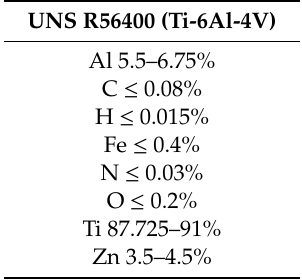
Table 7. Chemical composition of UNS R56400 (Ti-6Al-4V) specimens.